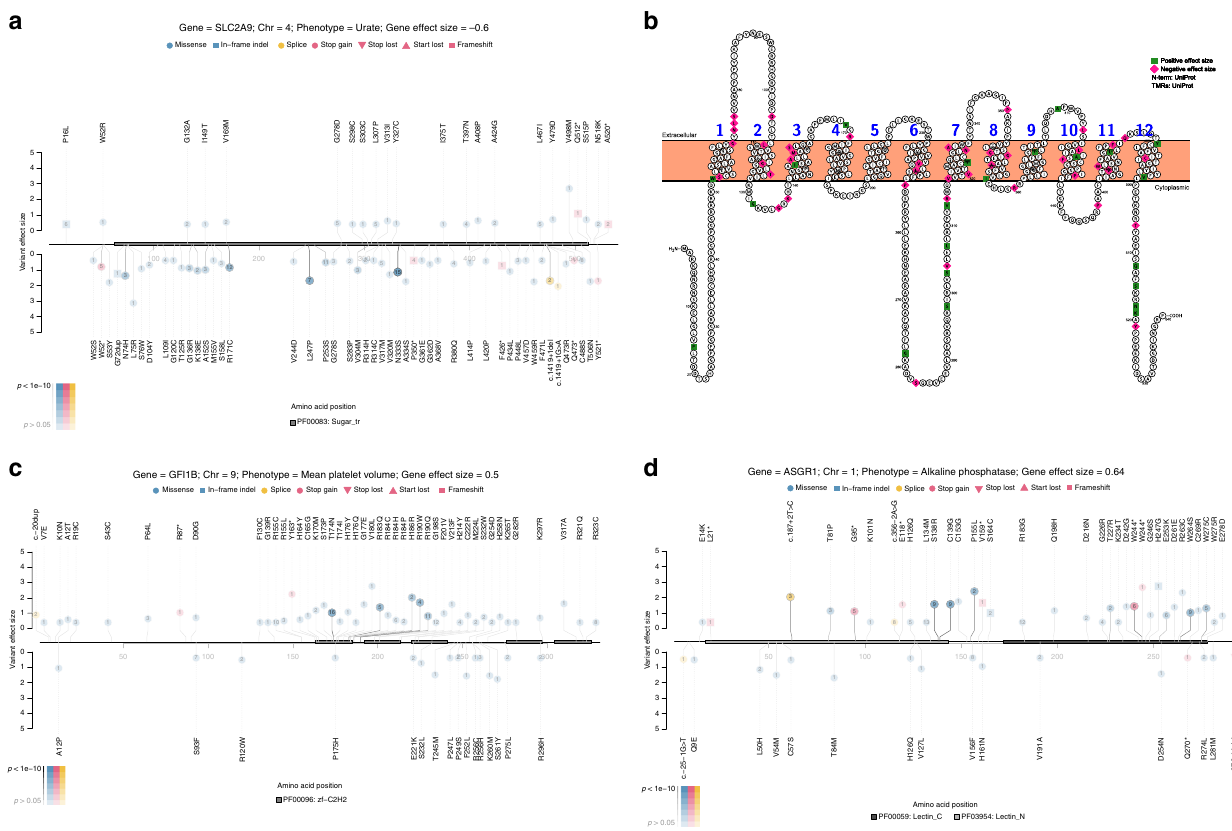
Fig. 4 Distribution of effects of rare variants in select genes in the UKB cohort. a SLC2A9 protein and urate levels. The legend shows the gene, its associated phenotype, and the effect size (beta). The effect size is computed from the gene-based collapsing model, in which individuals were coded as either having or not having a qualifying variant. A positive value indicates that variant carriers have, on average, higher values for the phenotype, while a negative value indicates that variant carriers have lower values. The amino acid positions are shown on the x -axis, with the PFAM domain highlighted. The y -axis displays the beta of each individual variant, with negative values shown below and positive values above the horizontal axis. Variants are indicated according to their consequence as shown and labelled according to their amino acid change or splice site variation. The number inside the circle is the number of people carrying that variant. Darker lines connecting the variants to the gene and darker- fi lled shapes indicate more signi fi cant p values for the association. b Membrane topology plot of SLC2A9 showing variants with positive effect size (green) on urate levels and variants with negative effect size (pink). SLC2A9 (Glut9) reabsorbs urate in the proximal tubules of the kidneys. Variants that disrupt the transmembrane regions or lower gene expression are known to be associated with hypouricemia 29 . Here, 88% of the variants with negative betas, associated with lowered urate levels, are in or directly adjacent to a predicted transmembrane region, as opposed to only 55% of the variants with positive effect size. c GFI1B protein and mean platelet volume. Consistent with the literature, variants in the zinc fi nger domains are associated with increased platelet volumes, but we make the observation that some variants in between zinc fi ngers 3 and 4 may be having an effect in the opposite direction 30,31 . d ASGR1 protein and alkaline phosphatase levels. In addition to the known effects of LoF variants, we show that missense variants are also playing a role 32 . Plots of the other signi fi cantly associated genes are included in Supplementary Fig.